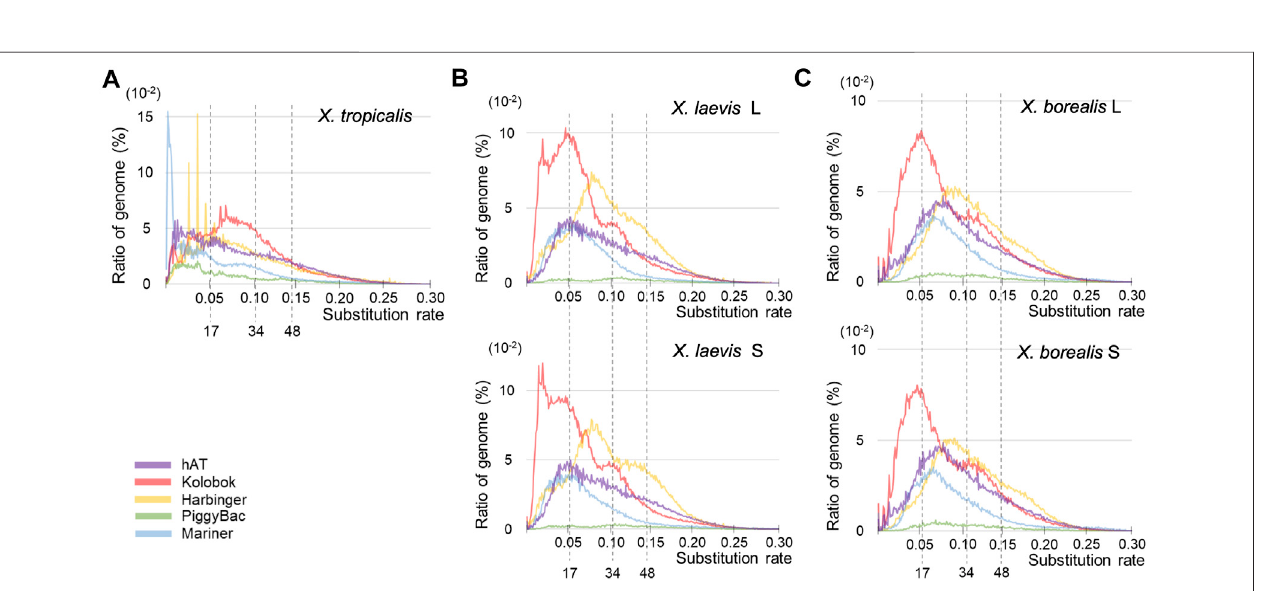
Frontiers in Genetics |